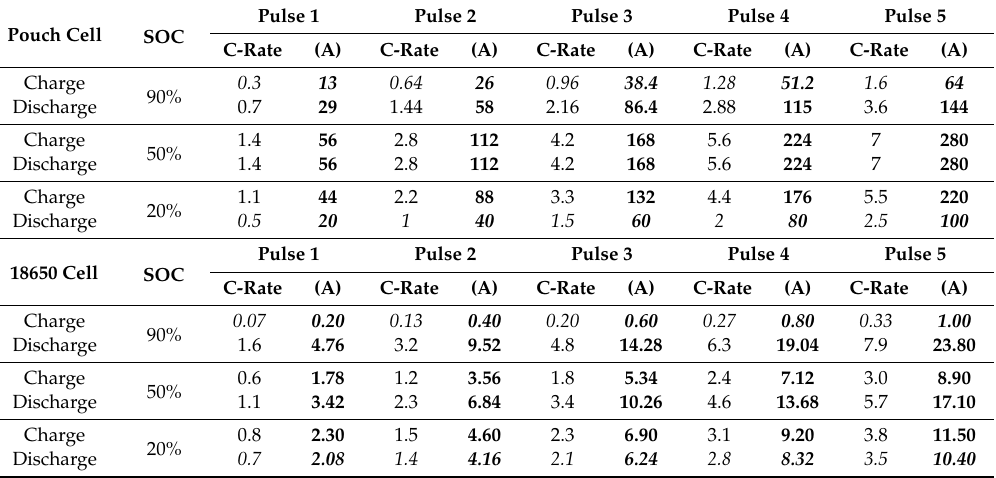
Table 3. Hybrid Pulse Power Characterisation (HPPC) currents at 25 ◦ C.